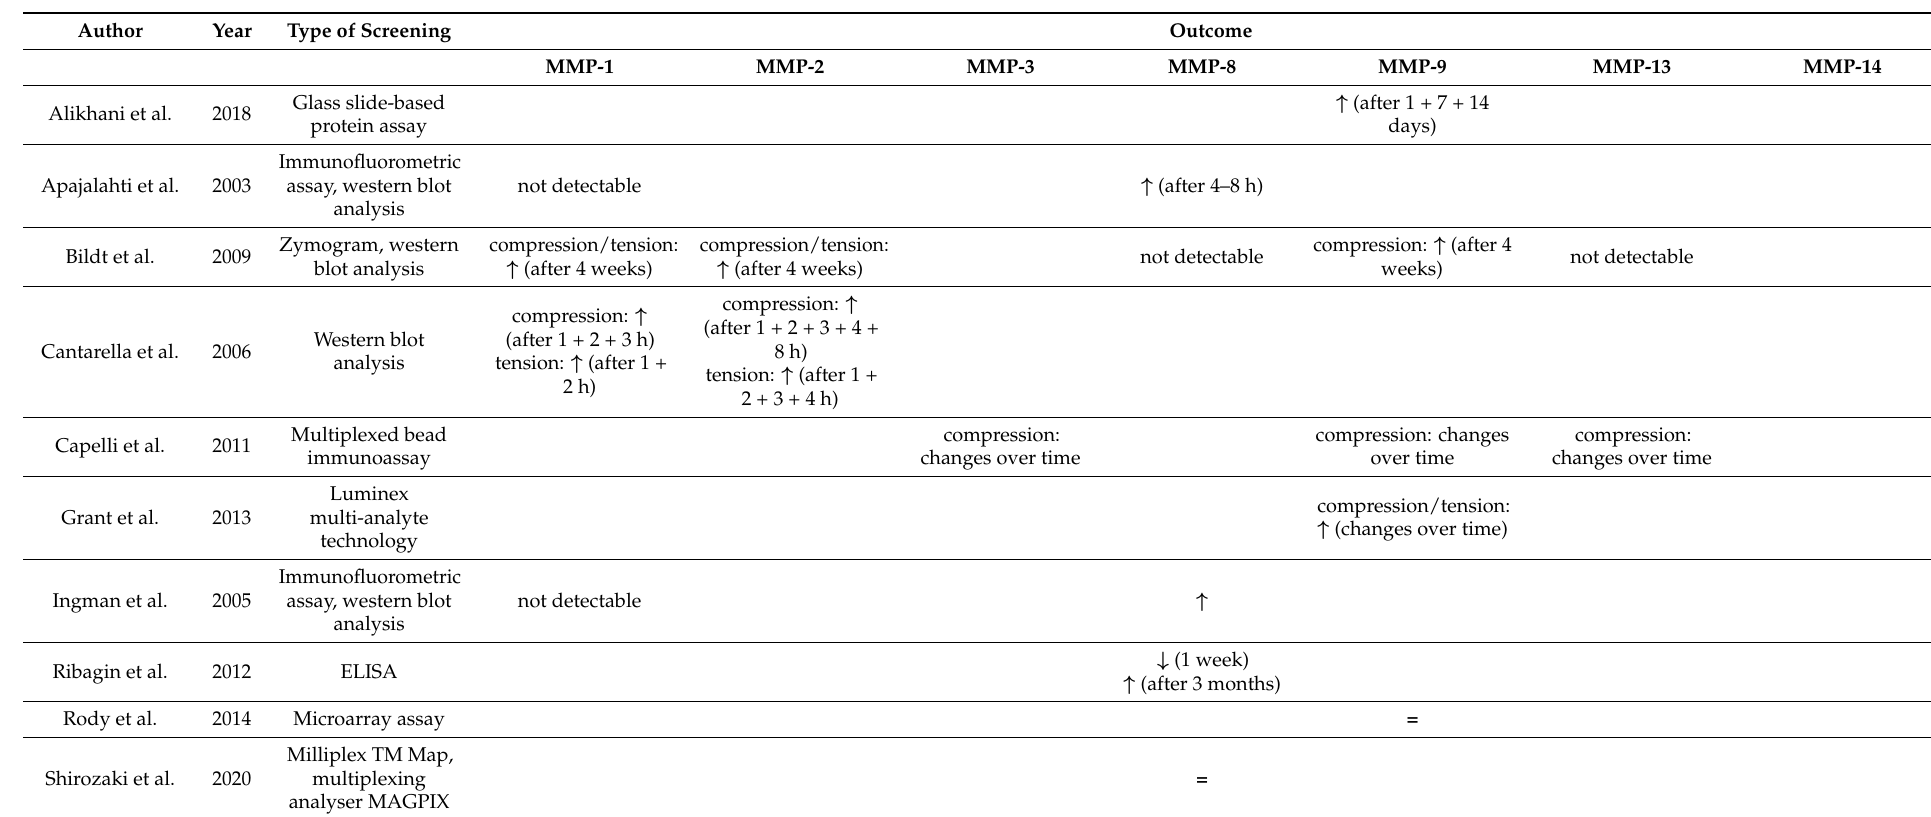
Table 7. MMPs outcome of all included in vivo